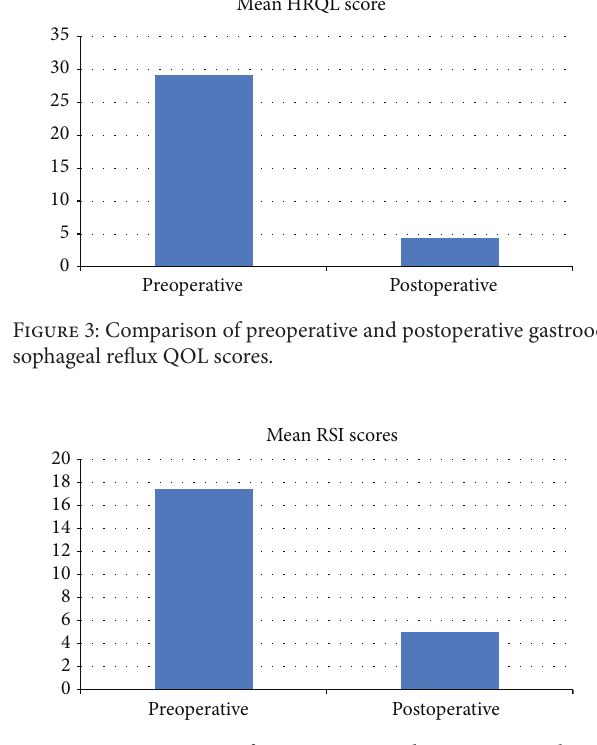
Figure 4: Comparison of preoperative and postoperative laryn- gopharyngeal reflux QOL scores.